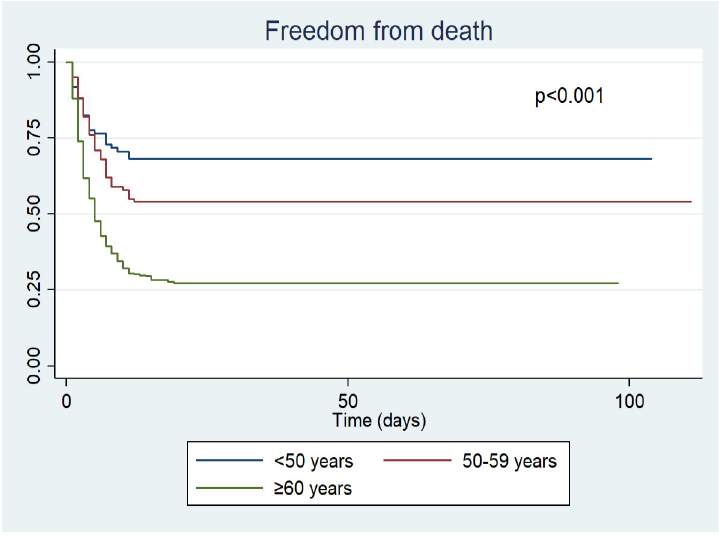
Figure 2. Survival analysis by age groups of the